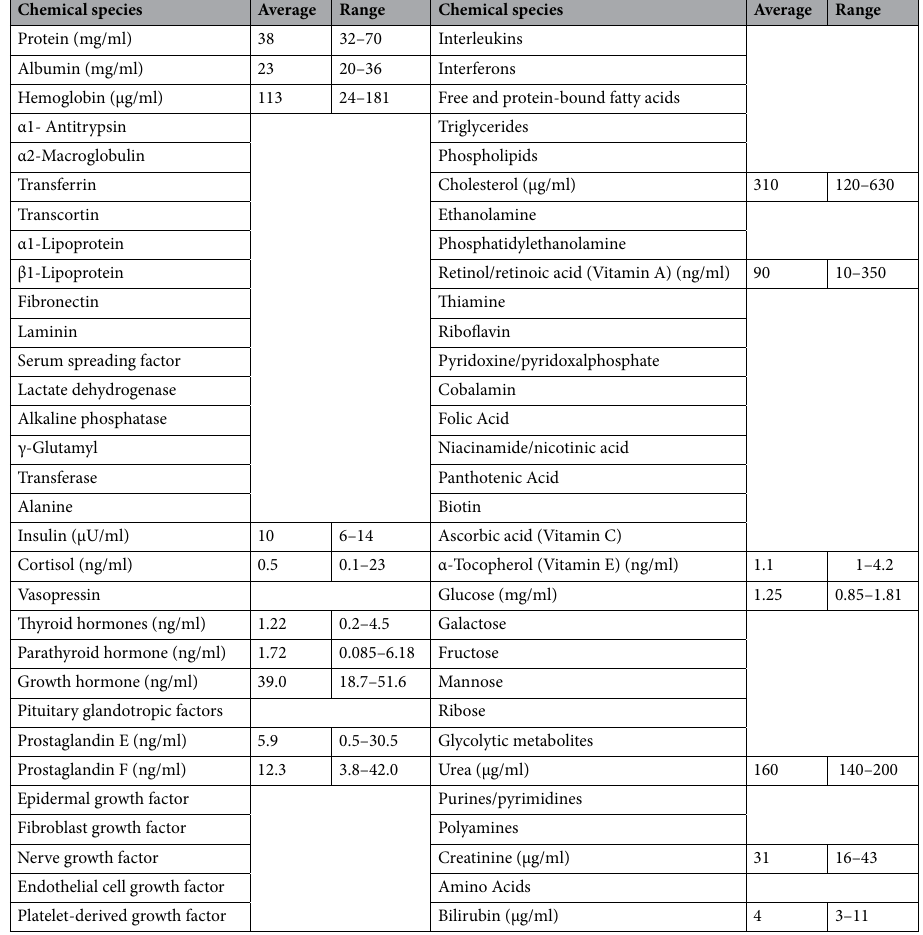
Table 3. Typical components found in BS. Averages and range estimates of concentrations given when available. *Note that the exact composition of BS is unknown, the above table provides only estimates of concentrations and constituents 40,41 .